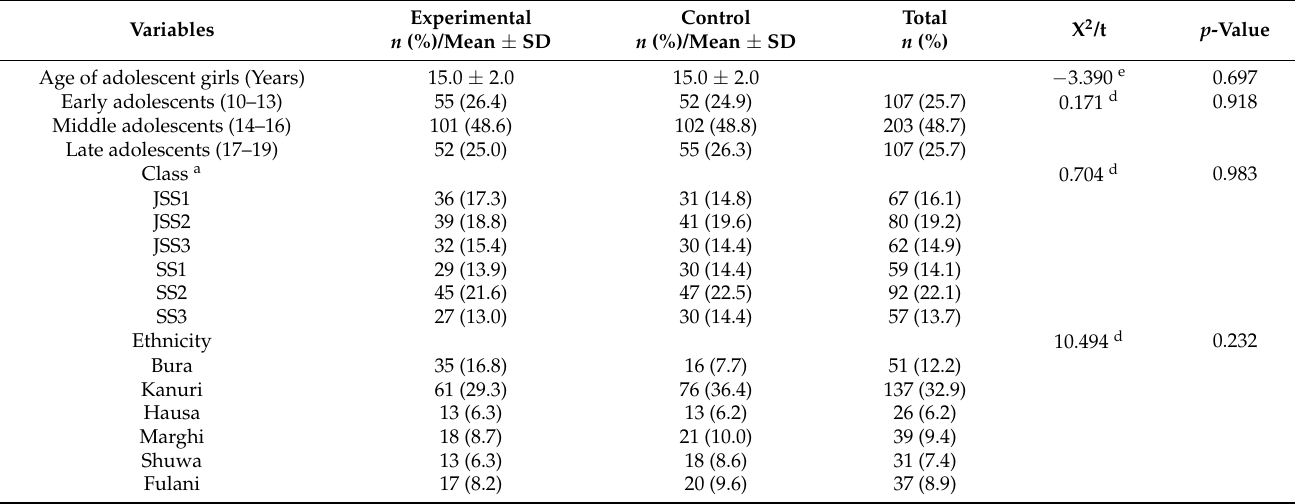
Table 2. Baseline Comparison of Sociodemographic Characteristics Between Intervention and Con- trol